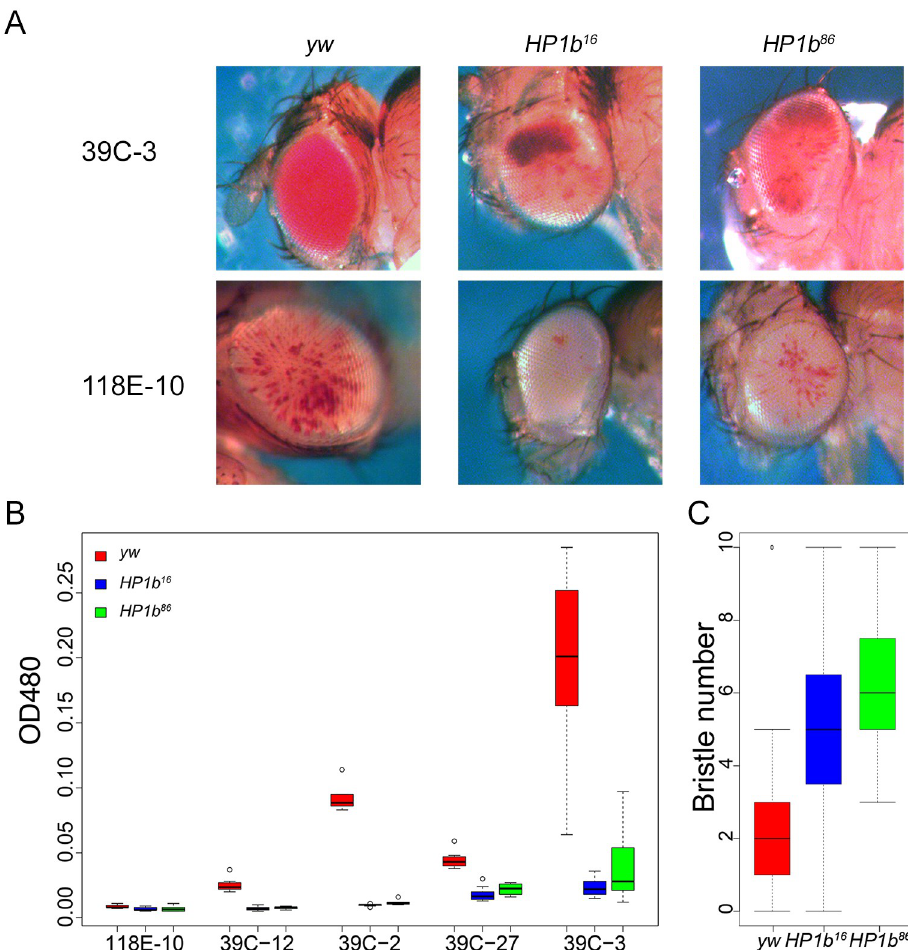
Fig 3. HP1b is an enhancer of variegation. A . If mutant HP1b alleles are introduced into stocks carrying hsp70-white reporter genes, the red eye color (reflecting white expression) is decreased compared to the yw control in male flies. Representative eye pictures are shown from males for two of the reporter insertions, 39C-3 located in the pericentric region of chromosome 2, and 118E-10 located in the pericentric region of chromosome 4. B . Quantitative eye pigment assays for males from the five reporter insertions assayed. All comparisons of mutant eye pigment values to the yw control are statistically significant (p < 0.05, t-test). X-axis: reporter insertions. Y-axis: OD 480 measuring eye pigment. Results from the yw control are in red, from HP1b 16 in blue, and from HP1b 86 in green. Box plots: black bar—median; box—+25% and -25% quartiles; whiskers—maximum and minimum; circles—outliers; n = 6–10. C . Stubble variegation assays indicate that HP1b is an enhancer of variegation, as the presence of the HP1b mutant alleles significantly increases the number of wildtype bristles compared to the yw control (p < 0.001, Tukey multiple comparisons of means; n = 19–39). Data from males. Results from the yw control are in red, from HP1b 16 in blue, and from HP1b 86 in green. Box plots: black bar—median; box—+25% and -25% quartiles; whiskers—maximum and minimum; circles—outliers. For data from females, see S1